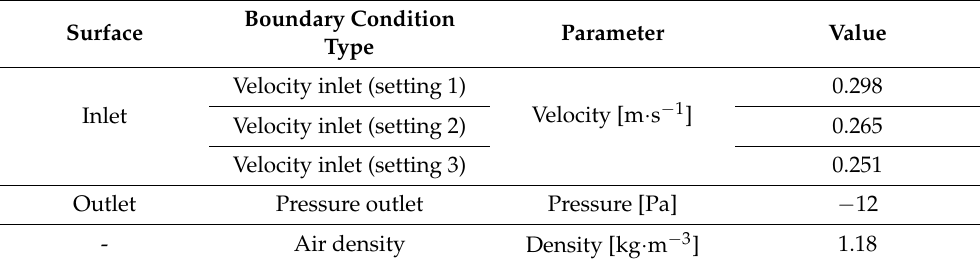
Table 3. Boundary